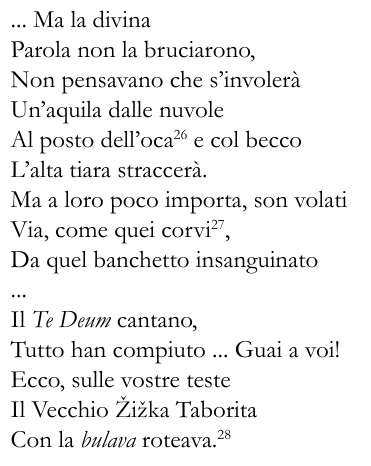
/ Замість гуся і розклює / Високу тіару . / Байдуже їм , розлетілись , / Мов тії ворони , / З кровавого того свята . ... Постривайте ! / Он над головою / Старий Жижка з Таборова / Махнув булавою . (Šev č enko 2003, 1: 295-296) [Trad. mia –